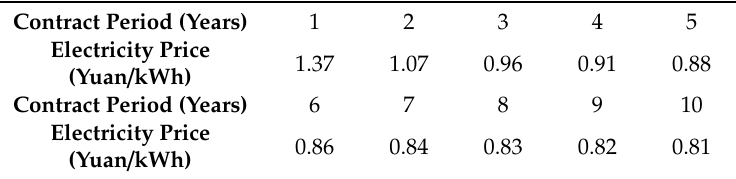
Table 4. Package price of di ff erent contract periods.